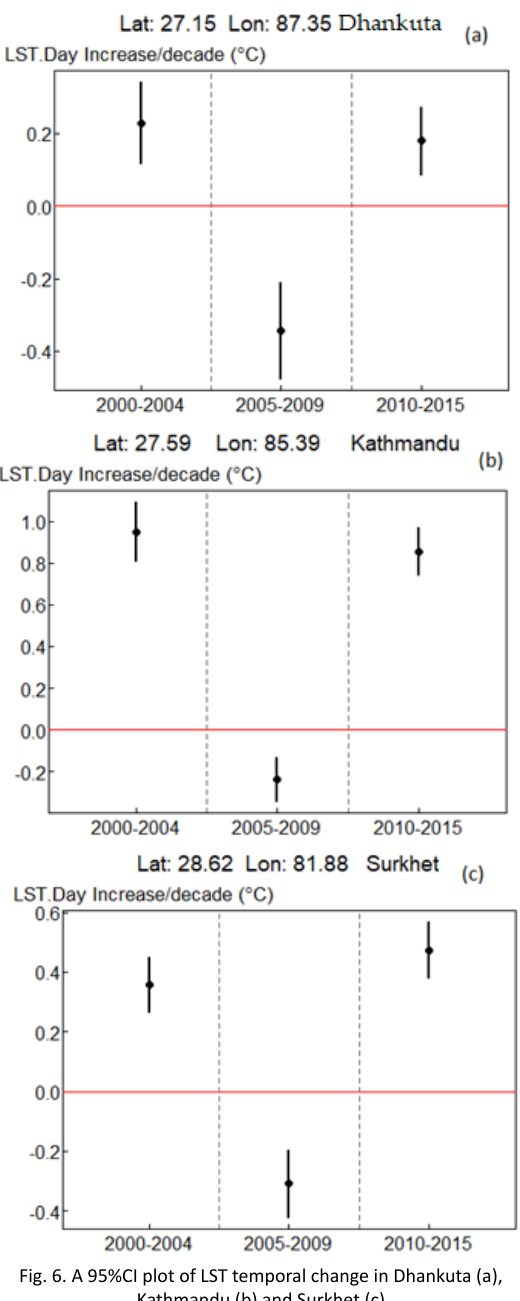
Fig. 6: A 95%CI plot of LST temporal change in Dhankuta (a), Kathmandu (b) and Surkhet (c)